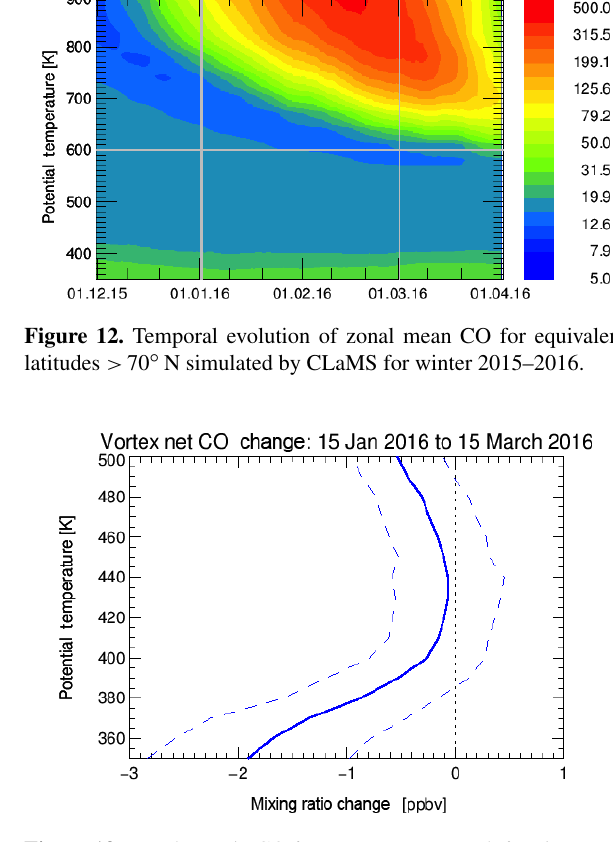
Figure 13. Net change in CO from January to March for air masses in the Arctic vortex (equivalent latitude > 65 ◦ N) due to chemical reactions in the stratosphere and mesosphere calculated by CLaMS. The blue line represents the statistical mean, the dashed lines repre- sent the 1 σ standard